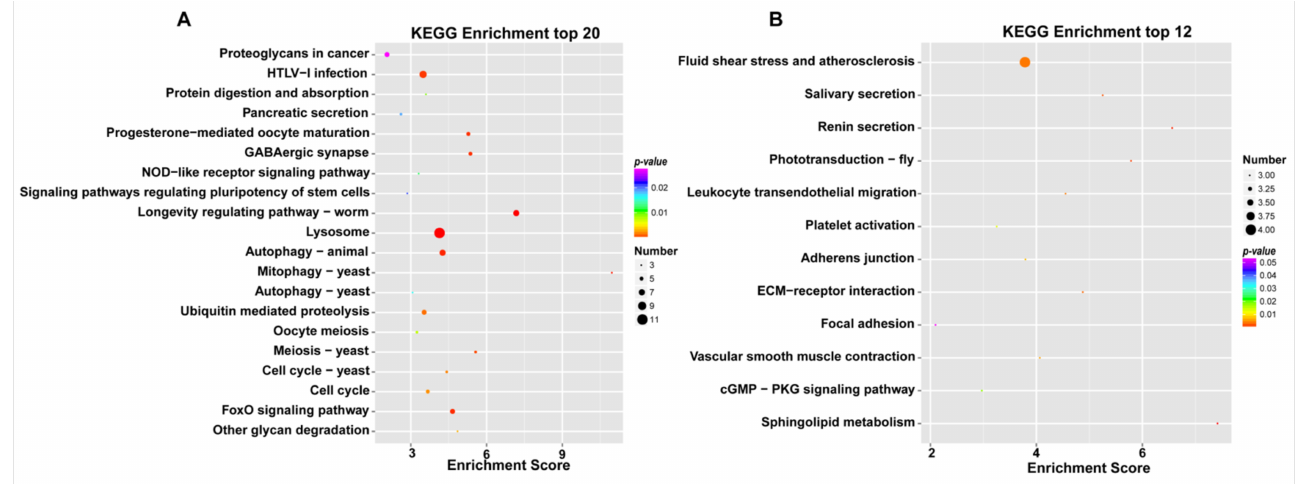
Figure 3. Bubble chart of KEGG enrichment of DEGs highly in the ovary ( A ) and testis ( B ). The x -axis in the figure is the enrichment score. The larger the bubble, the more differential the genes, the red-blue-green-yellow changes, and the enriched p-value increases.